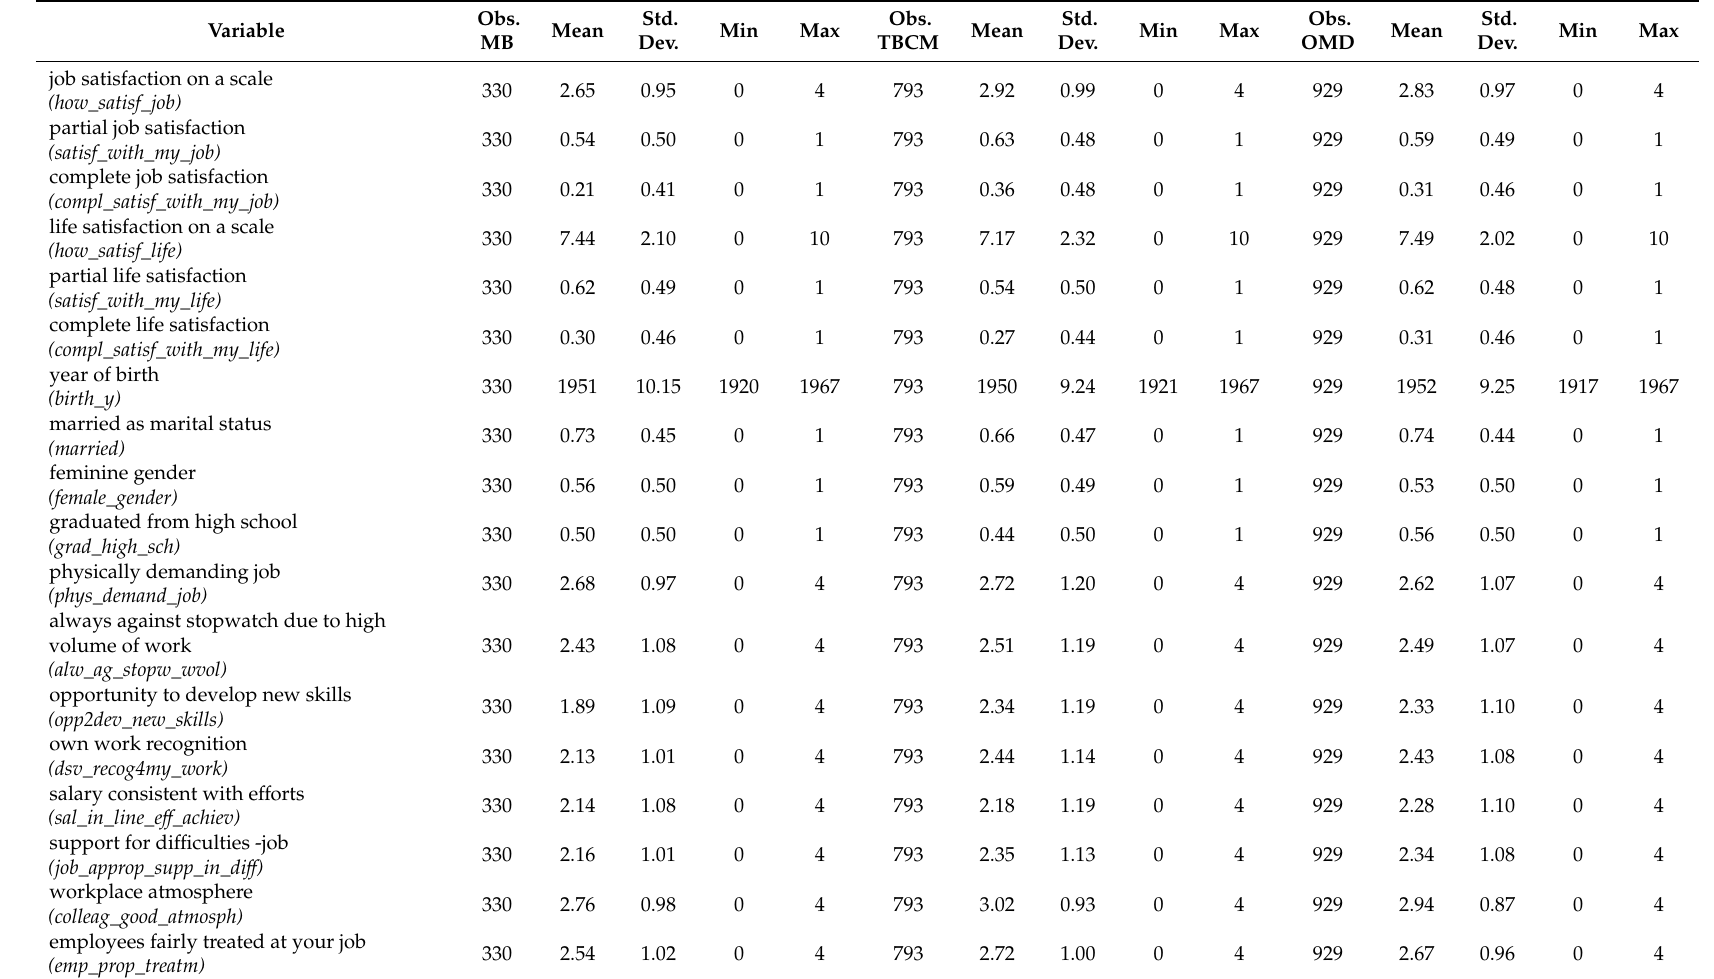
Table A2. Summary statistics for all three large historical